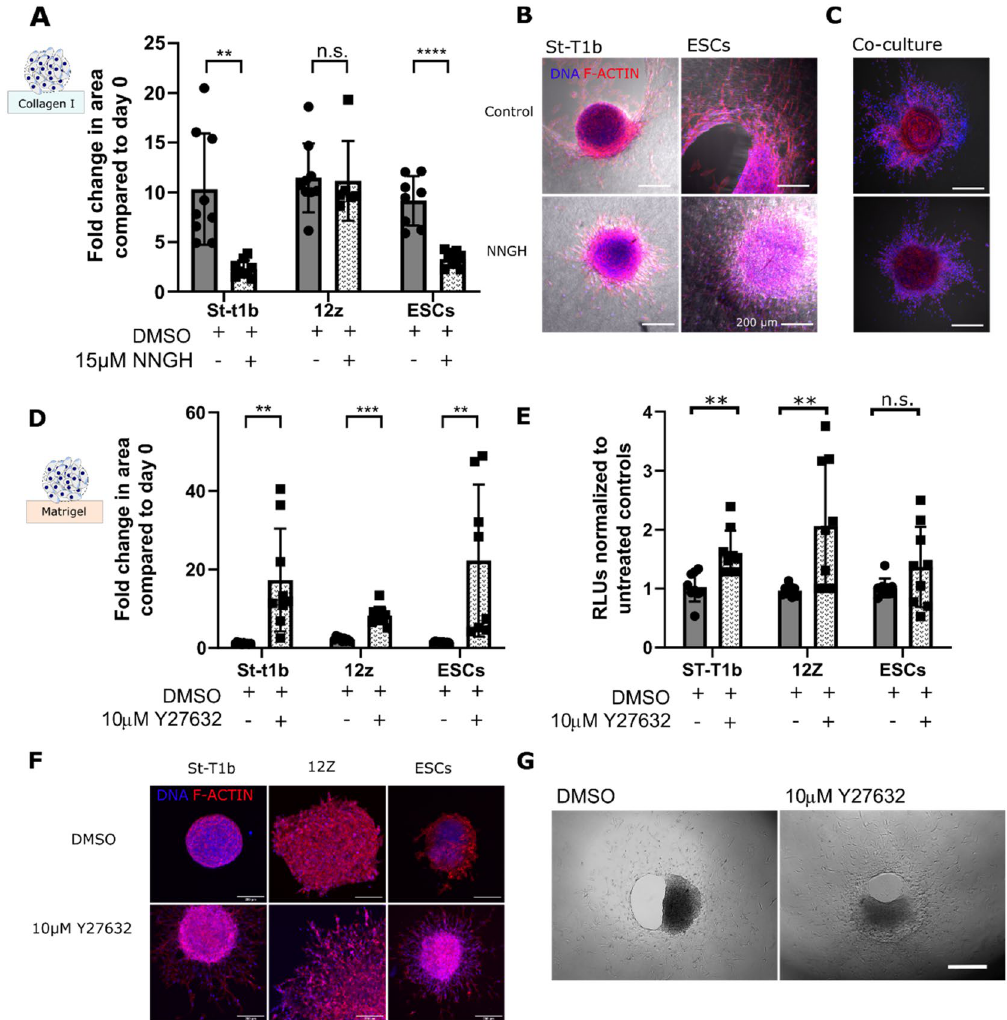
Figure 5. The effects of small molecule inhibitors on lesion formation. ( A ) The broad spectrum MMP inhibitor NNGH significantly reduced the in vitro lesion size in St-T1b and ESCs but not in 12Z cells that migrated on collagen I surface. The spheroid size was measured manually on days 0 and 5 (n = 6–9 independent wells across two preparations, multiple t tests). ( B ) NNGH effectively prevented stromal cells from degrading collagen I (bright field channel) but did not completely prevent the cells from migrating. Confocal images were obtained on fixed samples after 7 days in culture. Scale bar, 200 µm. ( C ) Co-cultures on collagen I without (top) and with (bottom) NNGH inhibitor on day 5 Scale bar, 200 µm. ( D ) The ROCK inhibitor Y27632 significantly increased the spreading of endometrial cells on Matrigel after 5 days. Data were compared to the spheroid size on day 0 using bright-field images (n = 8–10 independent wells across two different spheroid preparations, multiple t tests). ( E ) Y27632 significantly increases metabolic activity in all studied cell types on day 5 (n = 8–9, multiple t tests, three independent preparations). ( F ) Confocal images demonstrating the increase in the projected area of spheroids of all cell types on Matrigel upon Y27632 treatment Scale bar, 200 µm. ( G ) ESCs on Collagen I on day 7 with and without Y27632. Y27632 did not prevent collagen I remodeling. Scale bar 500 µm *p < 0.05; **p < 0.01; ***p < 0.001 and n.s. p > 0.05; Data shown as mean ±